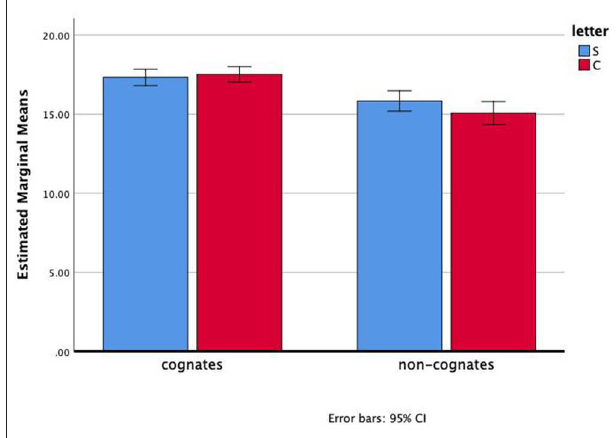
FIGURE 2 | Comparison between S and C words in cognates and